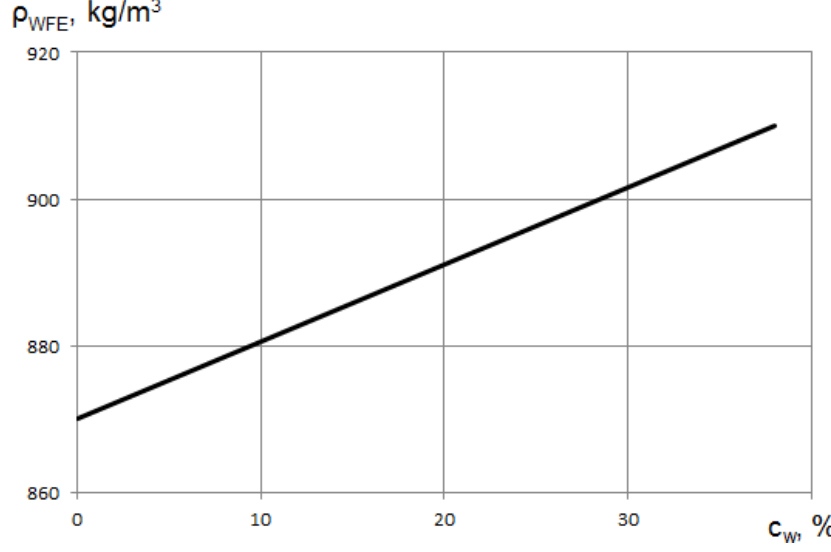
Figure 1. Influence of water concentration in water–fuel emulsion on its